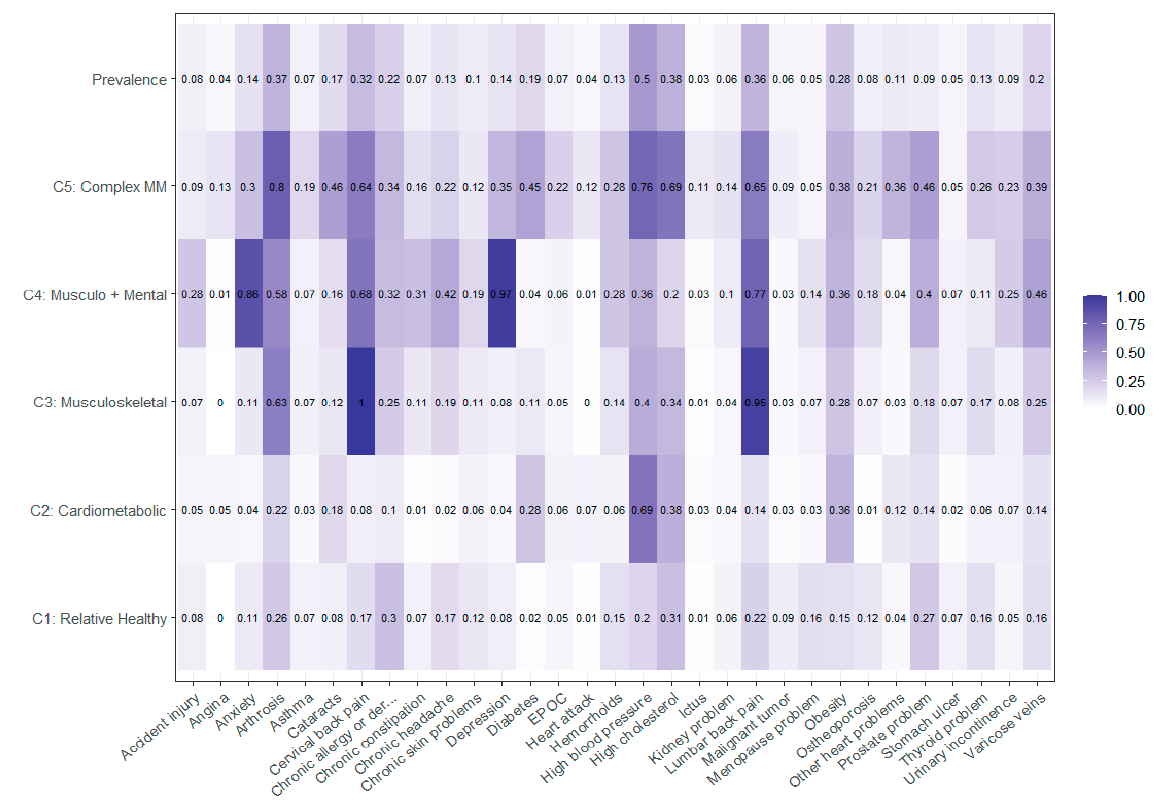
Figure 1. Final model of chronic conditions distribution in five classes and overall prevalence.